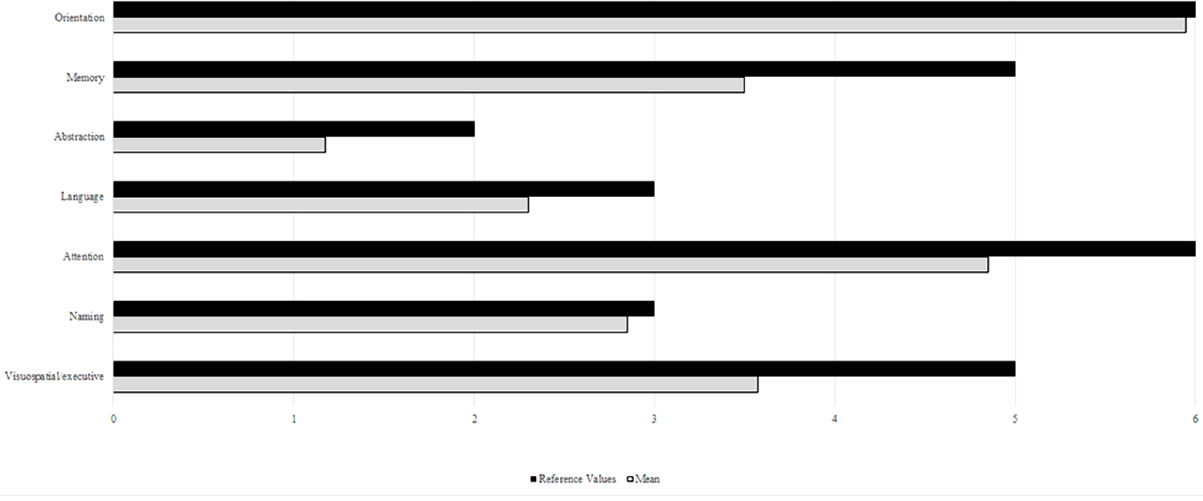
Figure 2- Reference values and mean values for the cognitive domains of the MoCA test Table 4- Pearson’s correlation analysis between ǂpredictors variables and response variables (cognitive